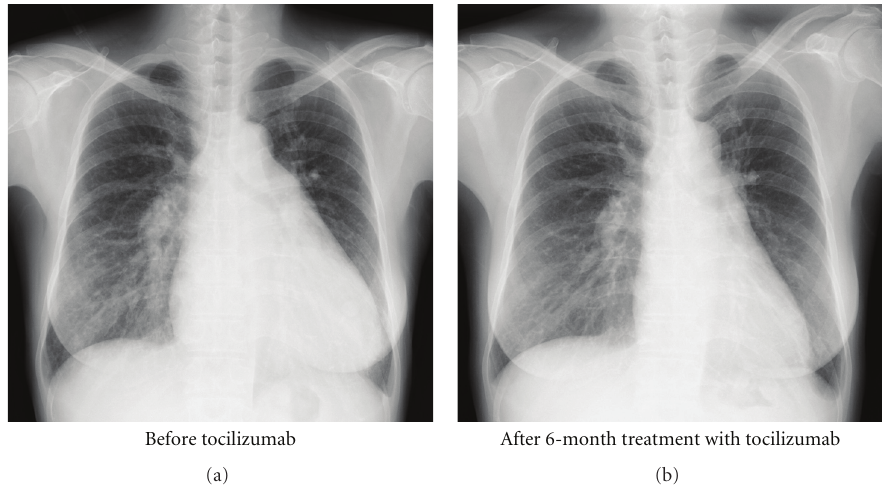
Figure 1: Chest X-ray before tocilizumab and after 6-month treatment with